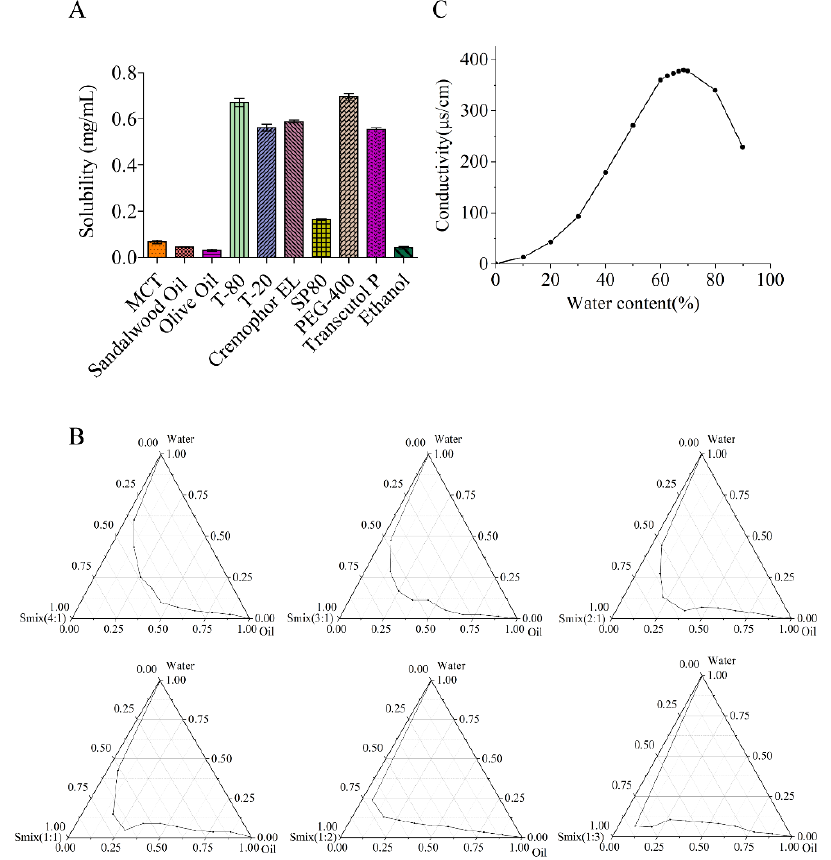
Figure 2. Preparation of IR-ME. ( A ) IR solubility in different oils, surfactants, and co-surfactants ( n = 3); ( B ) pseudo-ternary phase diagrams of the MCT/Cremophor EL/PEG-400/water system; ( C ) the curve of ME conductivity with water content.